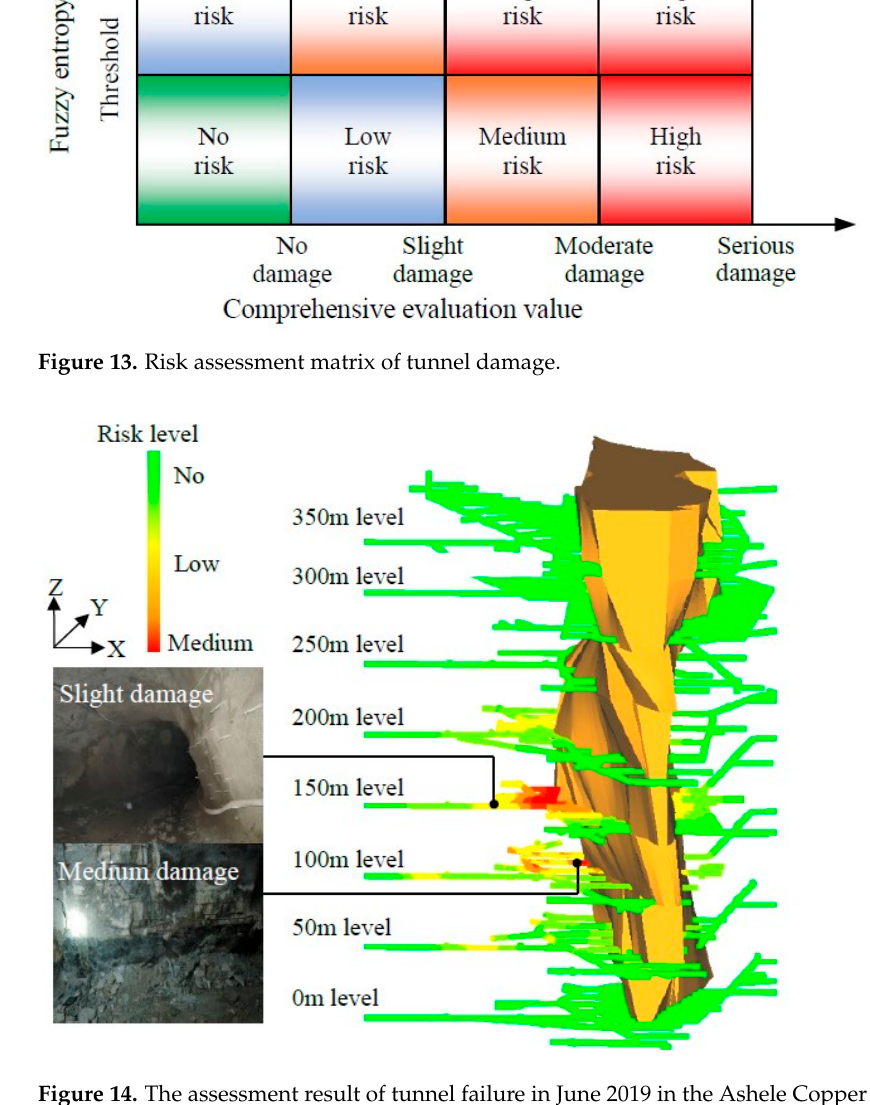
Figure 14. The assessment result of tunnel failure in June 2019 in the Ashele Copper Mine.